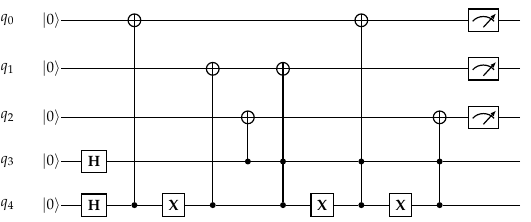
Figure 5. An example of a quantum circuit showing a sequence of quantum gates, the first of which are two H gates applied to q 3 and q 4 , followed by a CX gate with q 4 as a control to flip the state of q 0 and so